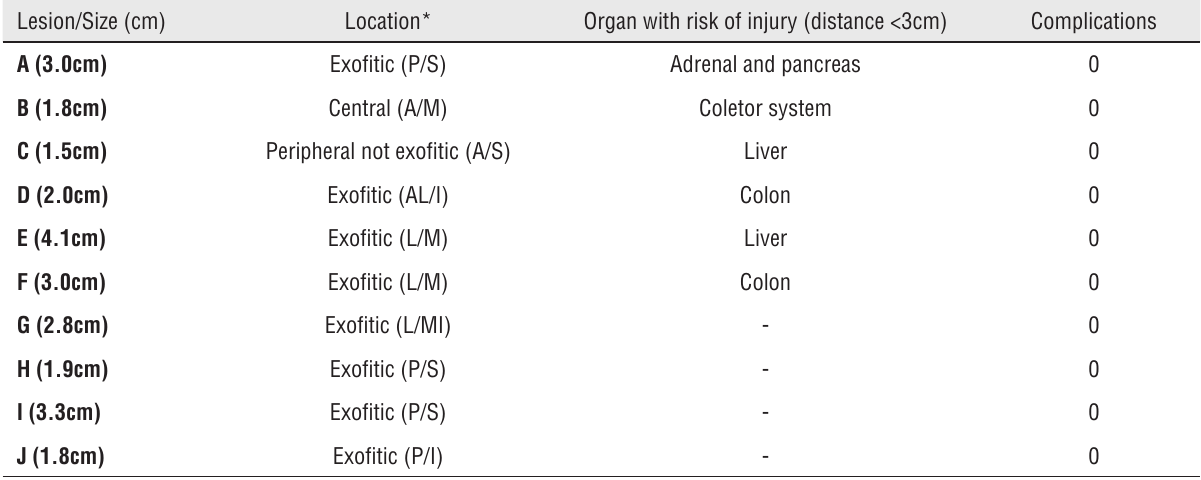
Table 2 - Characteristics of the Bosniak Iv cysts, with location and risk of adjacent organs injury. Lesion/Size (cm) Location* Organ with risk of injury (distance <3cm)